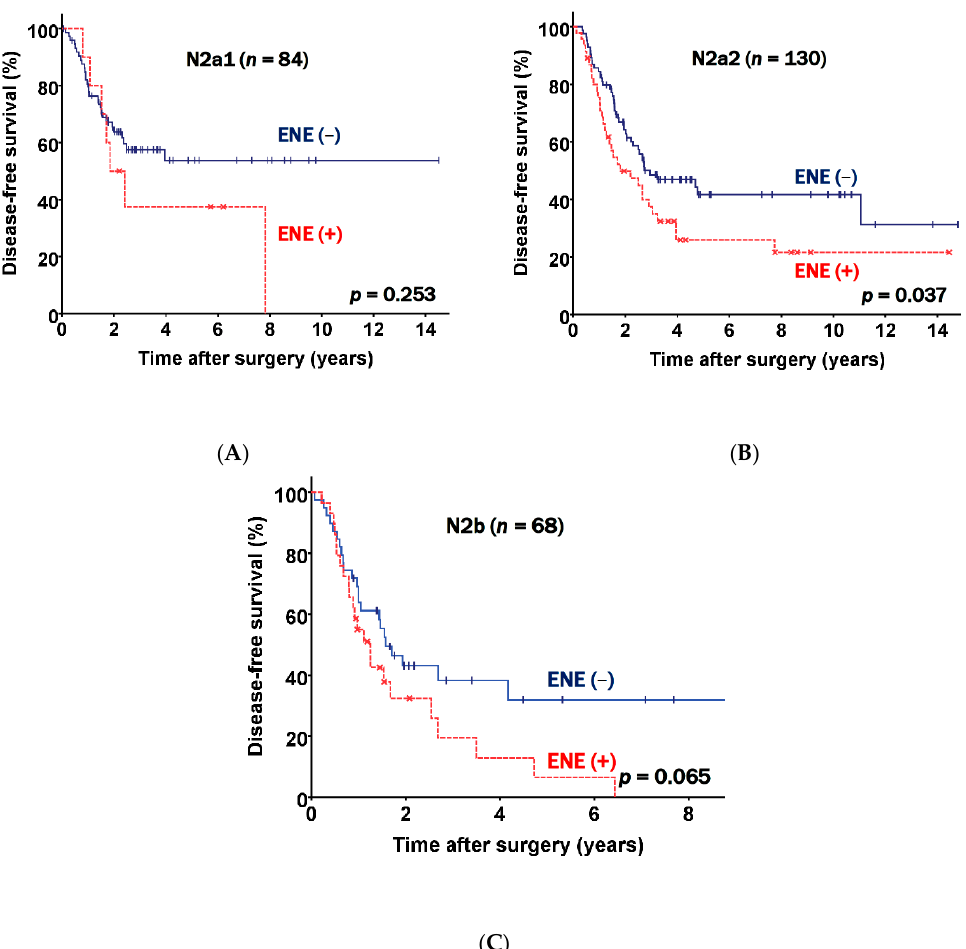
Figure 3. Disease free survival curves classified according to nodal status and extranodal extension (ENE) status. ( A ) N2a1 patients. ( B ) N2a2 patients. ( C ) N2b patients.